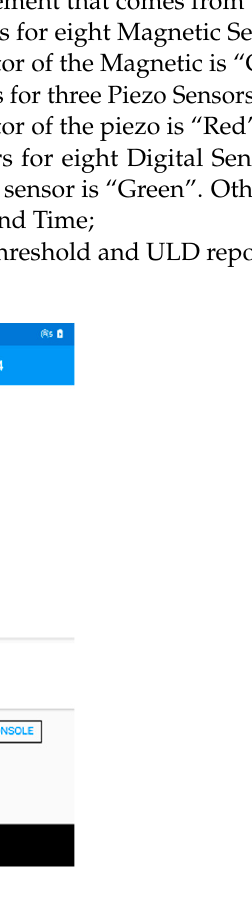
Figure 12. ULD Information ( left ) and Raw Data ( right ) Page.